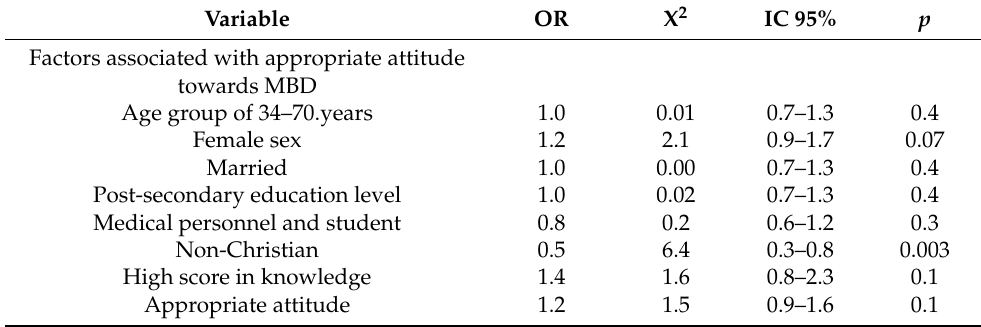
Table 11. Factors associated with good practice towards mosquitoes and mosquito-borne viral diseases (MBVDs) in